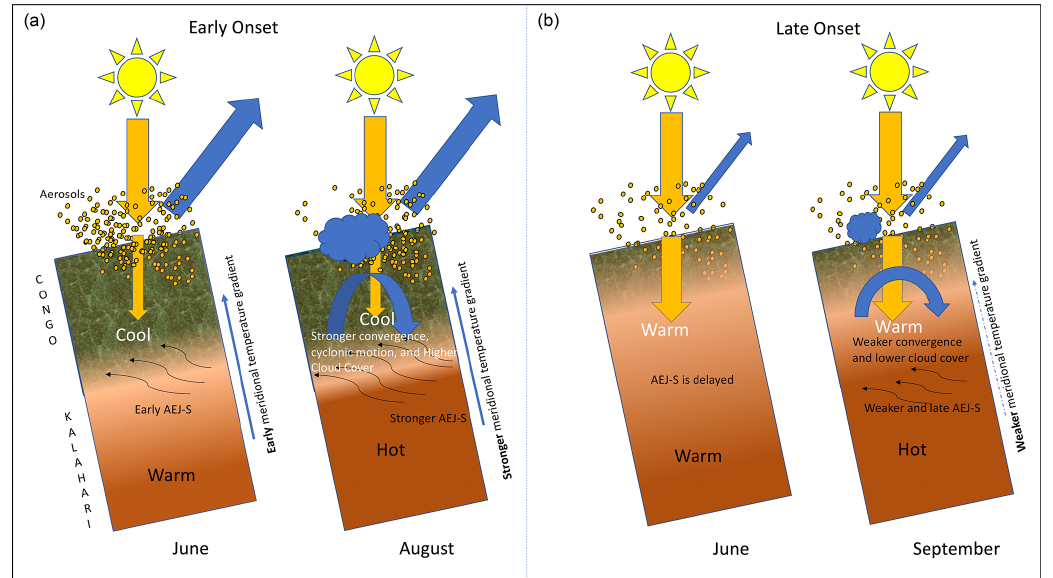
Figure 8. Schematics showing the early (a) and late (b) wet season onset